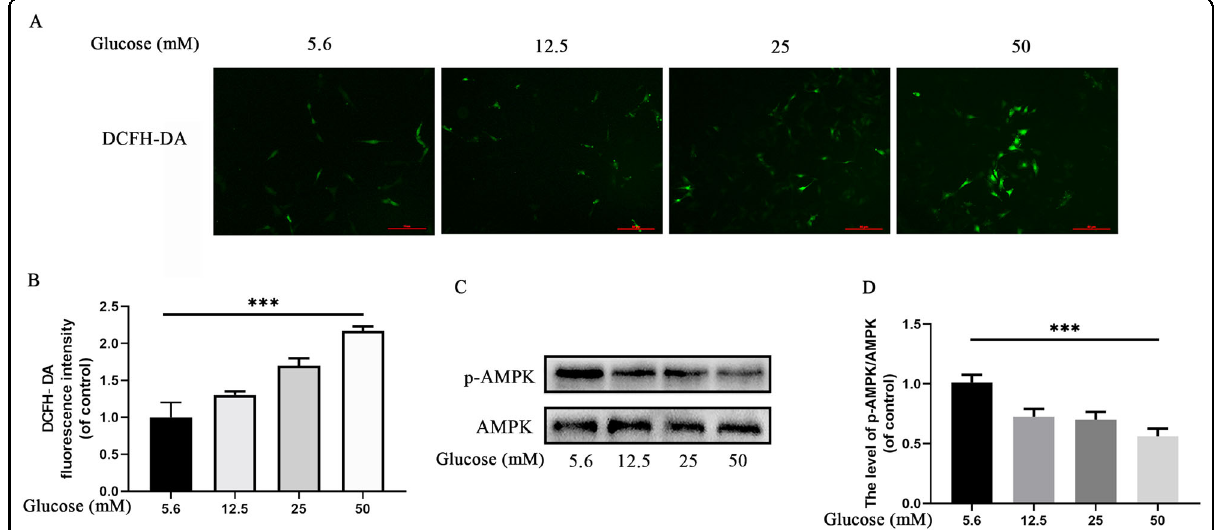
Fig. 2 High glucose induces (5.6, 12.5, 25, and 50 mM) oxidative stress and suppresses AMPK signaling in chondrocytes. A Representative micrographs of DCFH-DA staining representing the levels of ROS in chondrocytes. Scale bar = 50 μ M. B DCFH-DA fl uorescence intensity of chondrocytes treated with various glucose concentrations. C Expression and quanti fi cation analyses of p-AMPK and AMPK in chondrocytes treated with various glucose concentrations. D Expression of p-AMPK/AMPK under various glucose concentrations. Data are presented as means ± SD ( n = 5). * P < 0.05, ** P < 0.01 , and *** P <